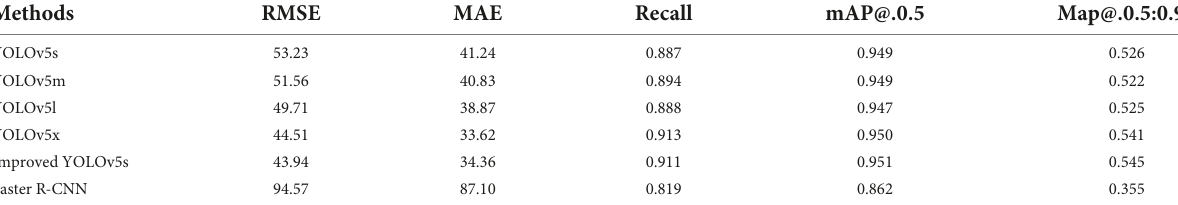
TABLE 2 Test performance comparison of different models. Methods